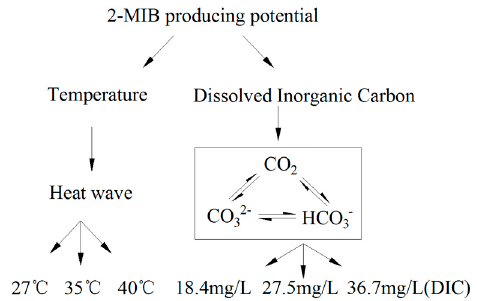
Figure 2. Technological roadmap.